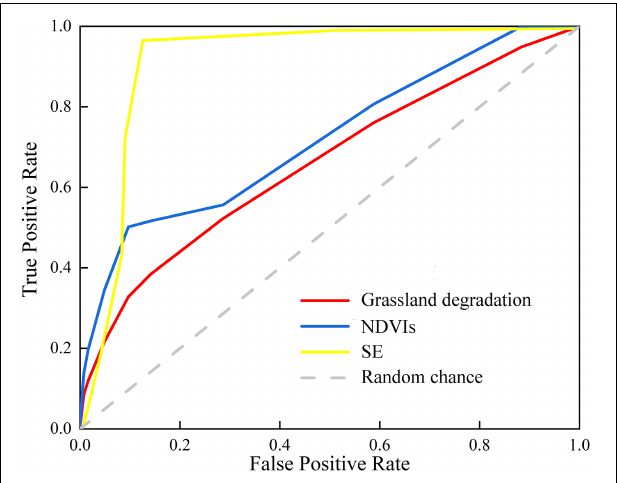
FIGURE 8 | ROC curve of NDVIs, shrub-encroached grasslands, and grassland degradation. NDVIs, slope of NDVI change; SE, shrub-encroached